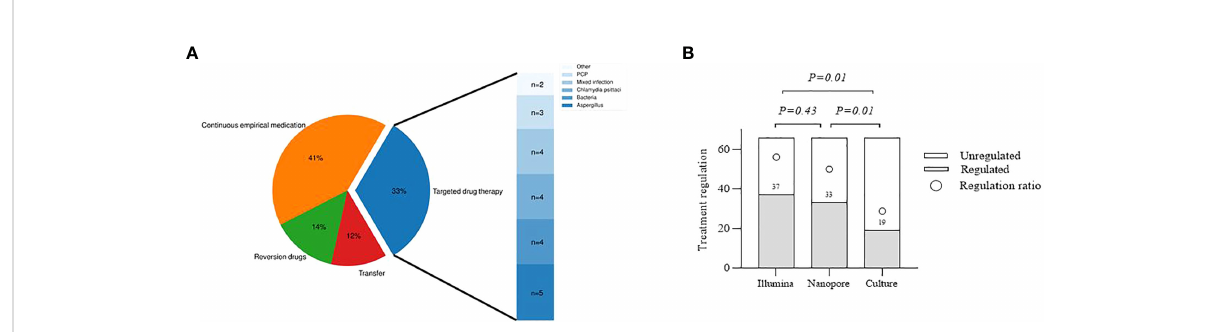
FIGURE 6 Evaluation of the clinical utility of the three methods. (A) , Distribution of antibiotic therapy and pathogens for targeted drug use. Continuous empirical medication, including unnecessary drug use for a speci fi c pathogen and empiric treatment for an unde fi ned pathogen. Transfer,